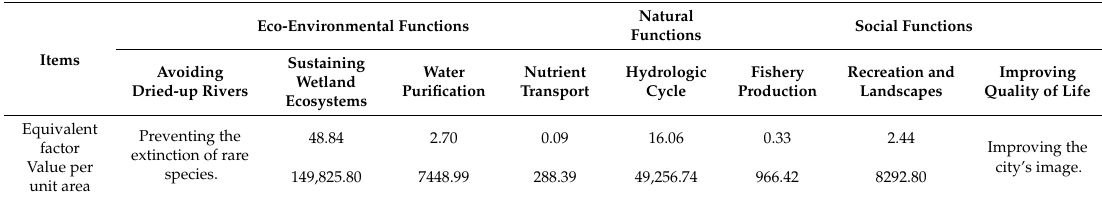
Table 5. The value equivalent factor of EBF in Wei River Basin. The equivalent factor is unitless; the unit of value per unit area is RMB/ha in 2015.